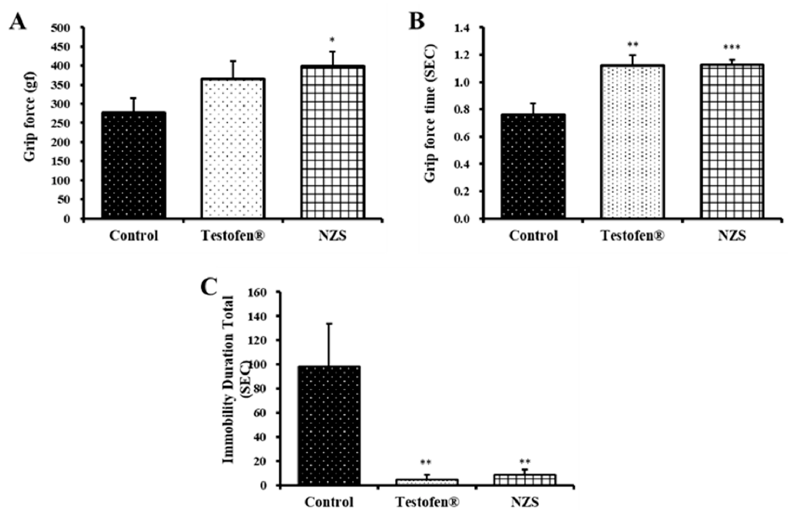
Figure 1. Effects of New Zealand spinach (NZS) extract on grip strength. ( A ) Force value indicates the pulling force in gf (peak force). ( B ) Resistance time during the test. ( C ) Immobility time for 12 min in forced swimming. Control, no administration of NZS extract; Testofen as a positive control; and NZS (300 mg/kg Testofen and NZS extract treatment group). Data are expressed as means ± standard error (n = 5). Symbols of *, **, and *** denote significant differences compared to aged rat (control) at p < 0.05, p < 0.01, and p < 0.001 levels, respectively.